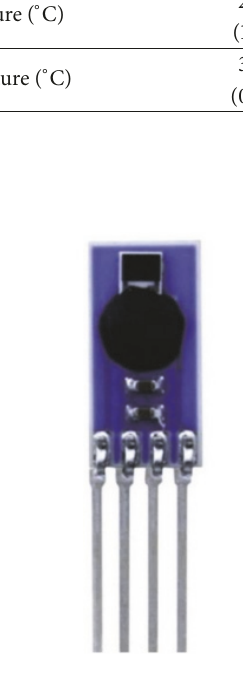
Figure 1: T and AH sensor: IST (cid:3) HYT 271 (machine side).